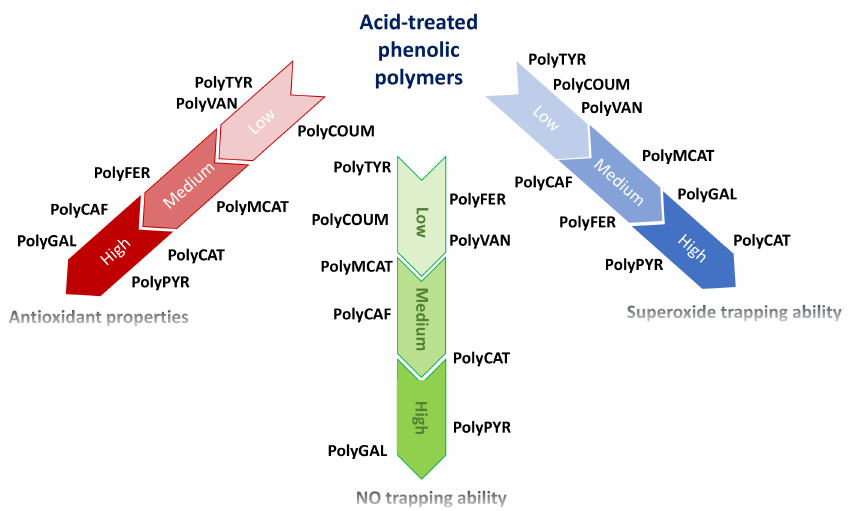
Figure 6. Overview of the antioxidant and radical-scavenging properties of acid-treated enzymatically synthesized phenolic polymers. Position along the arrows indicates the relative e ffi ciency of the polymers.